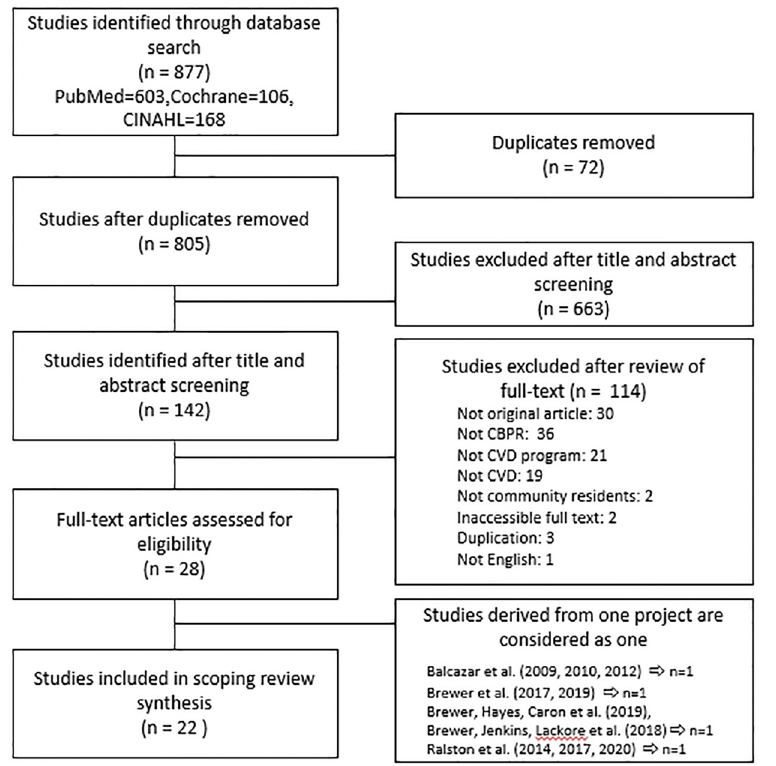
Fig 1. The sequential process of identifying the studies included in the